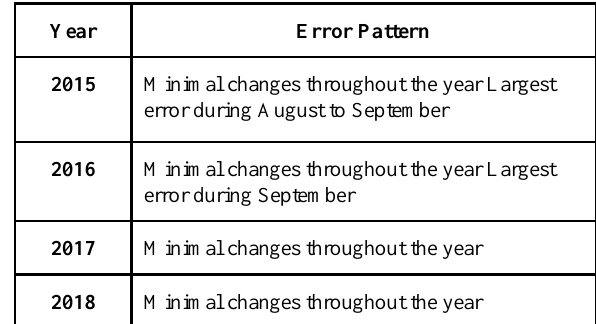
Table 6. Summary of the observed CT4 error patterns per